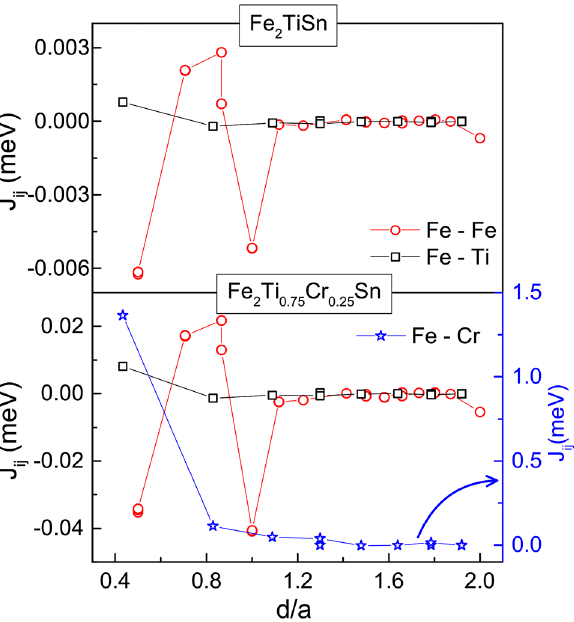
Figure 6. Heisenberg exchange coupling parameter, J ij , for Fe–Fe, Fe–Cr and Fe–Ti distances, plotted against the respective bond-distances normalized to the lattice parameter of the corresponding composition.